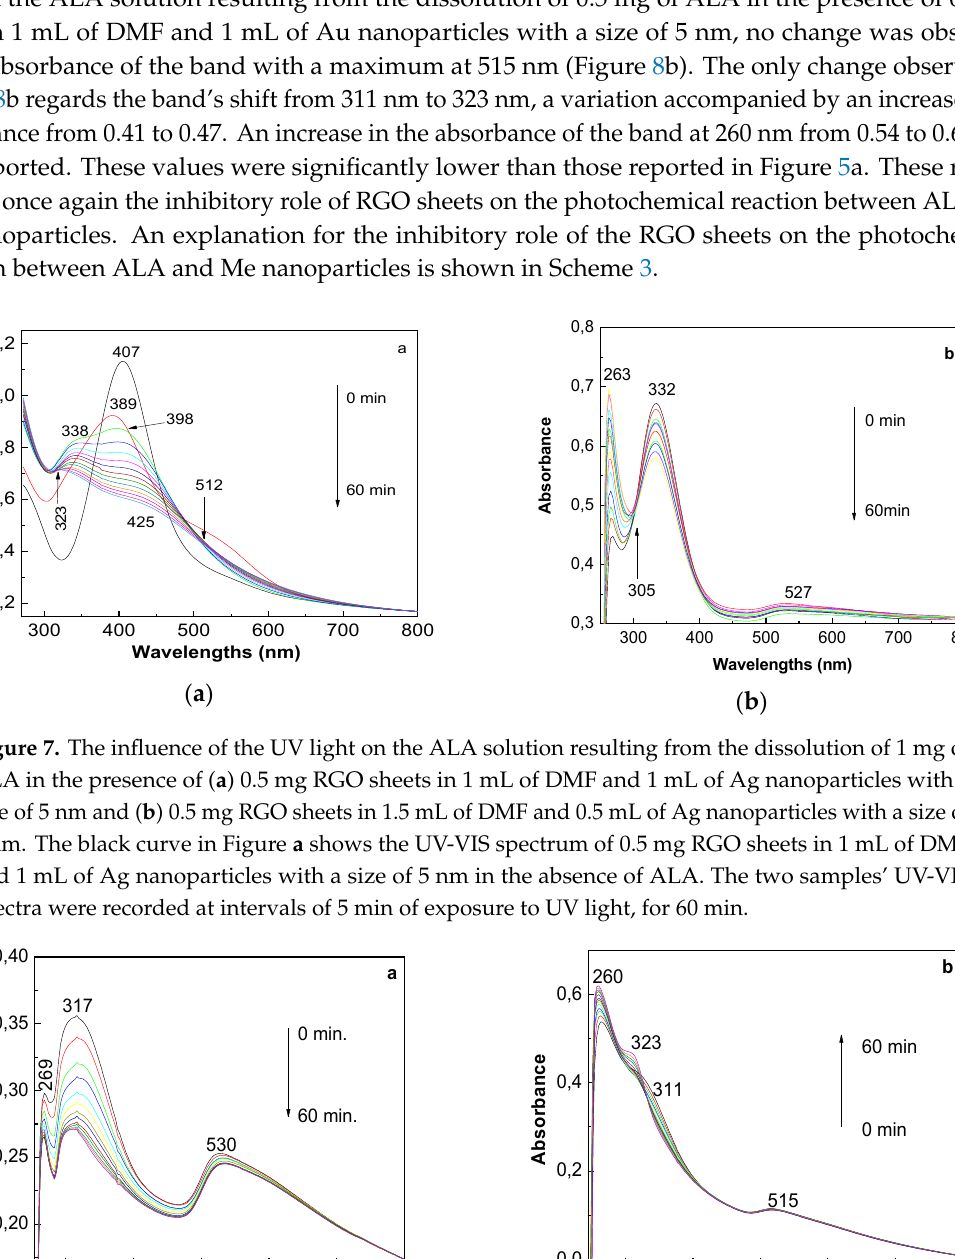
Figure 8. UV-VIS spectra of the ALA solution resulting from the dissolution of 0.5 mg in the presence of ( a ) 0.5 mg RGO in 0.5 mL of DMF and 1.5 mL of Au nanoparticles with a size of 5 nm and ( b ) 0.5 mg RGO in 1 mL of DMF and 1 mL of Au nanoparticles with a size of 5 nm, as well as their variations at exposure to UV light. The two samples’ UV-VIS spectra were recorded at intervals of 5 min of exposure to UV light, for 60 min.